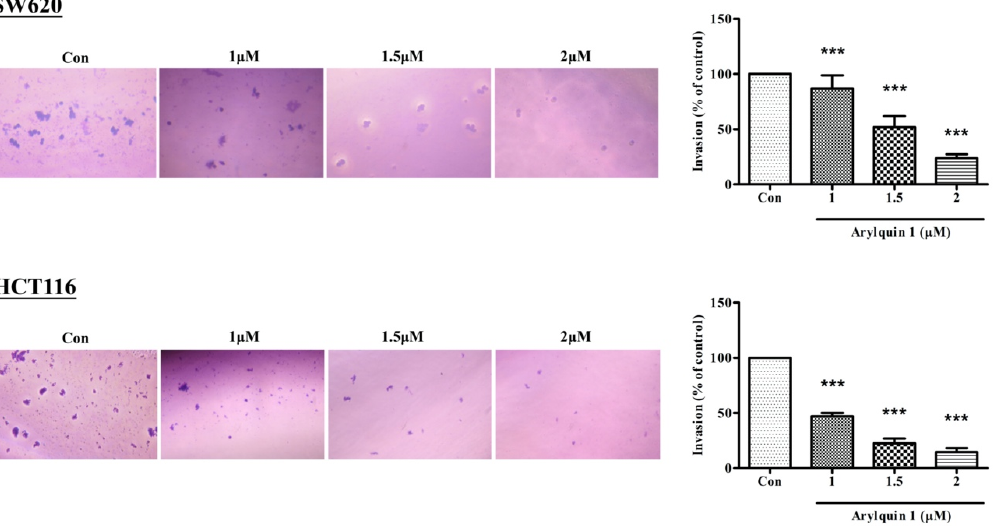
Figure 3. Wound-healing assay and percentage of cell migration in cultured SW620 and HCT116 cells 24 h after treatment with Arylquin 1; quantitative data are expressed as mean ± SEM. *** p < 0.001 compared to the control group.